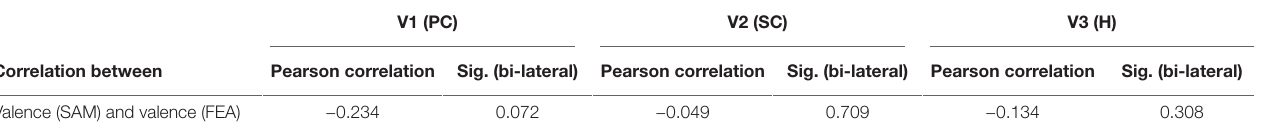
TABLE 4 | Correlation between valence (SAM) and valence (FEA).